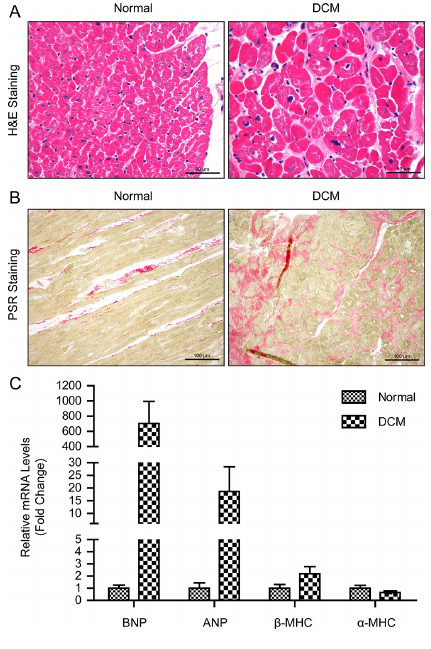
Figure 2. Pathologic and molecular prop- erties of human DCM hearts. (A) H&E staining of left ventricles of donor hearts (n = 12) and DCM hearts (n = 15) (scale bar 50 μ m). (B) Picrosirius red staining of left ventricles of human hearts (n = 12–15, scale bar 100 μ m). (C) Real-time PCR